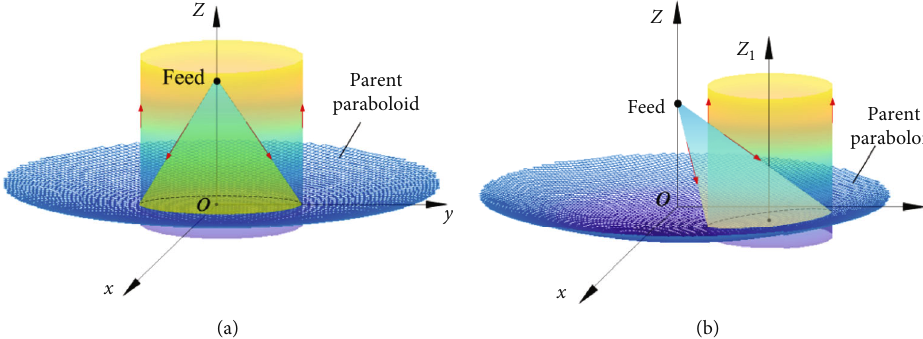
Figure 4: Types of parabolic antenna. (a) Normal feed. (b) O ff set feed.